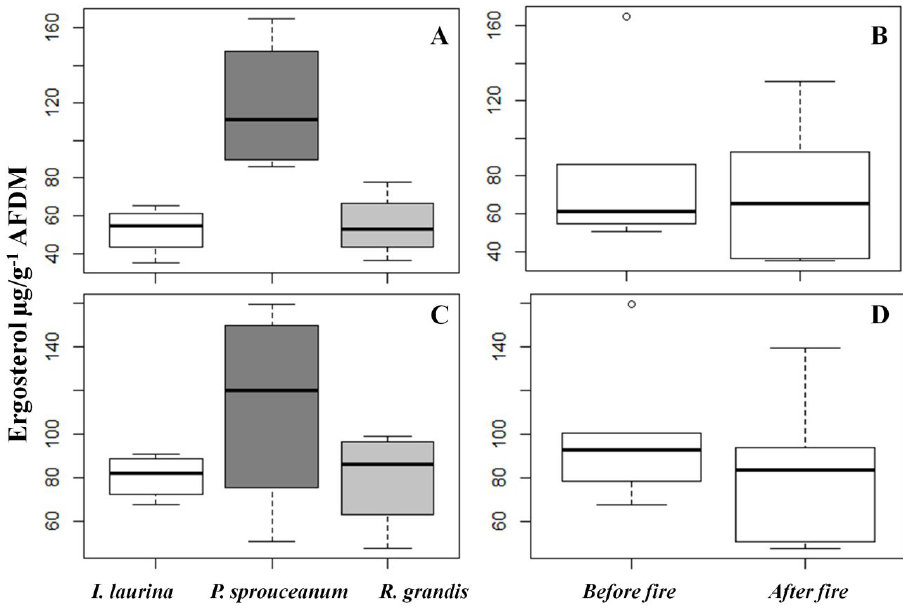
Figure 5. Fungal biomass (Ergosterol µg.g -1 ) in fine (A and B) and coarse (C and D) mesh litter bags for different leaf litter (A and C) before and after fire (B and C) in a stream in an ecotone between Savannah and Tropical Rain